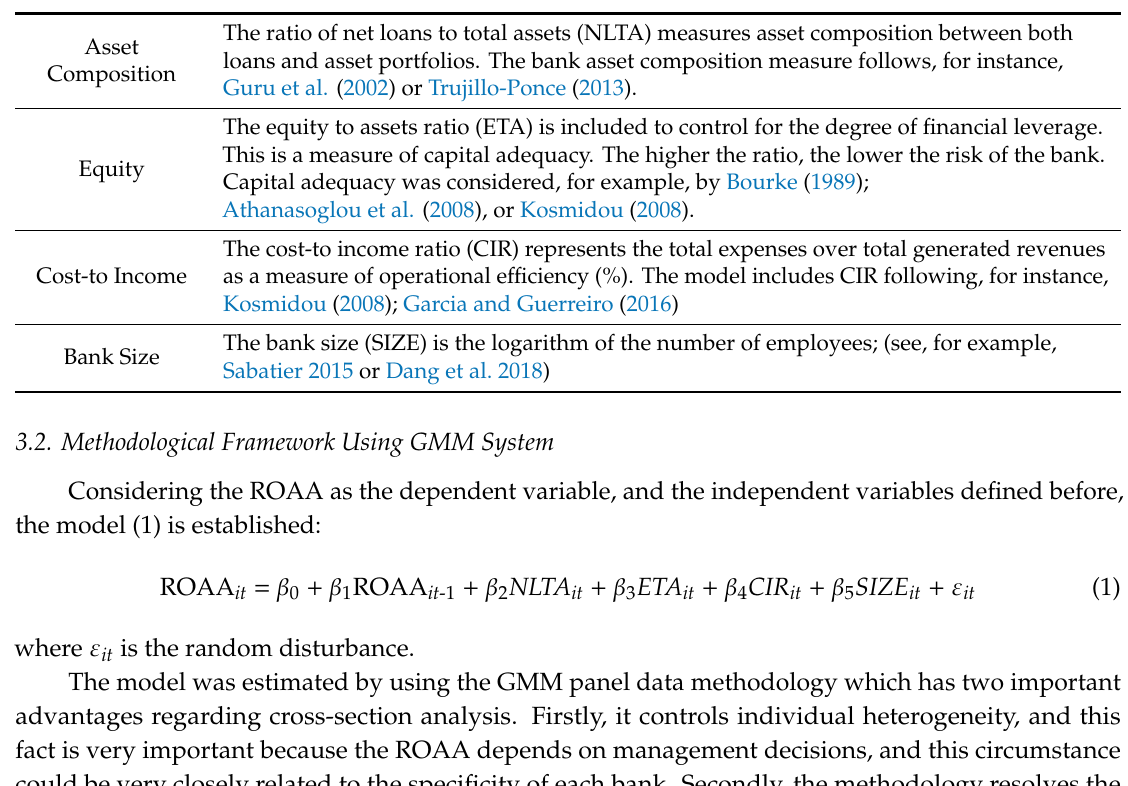
Table 1. Description of the explanatory variables. Bank-specific characteristics as determinants of bank return on average assets